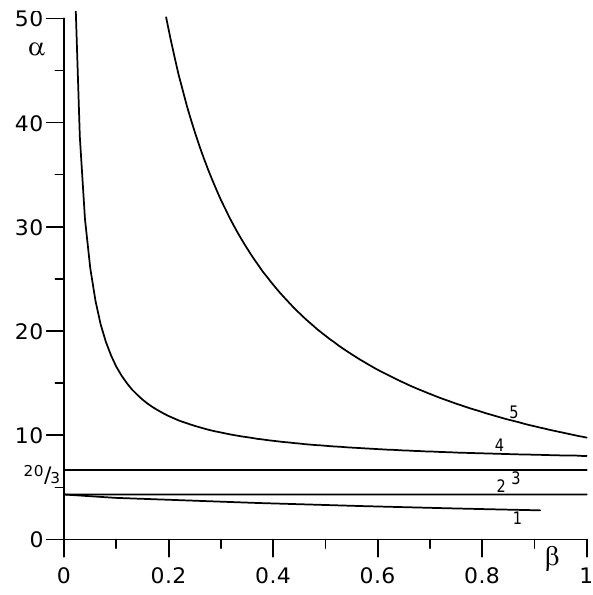
Fig. 4. Stability thresholds of the magnetospheric MHD modes: Flute modes (1 – nonlinear criterion (19), 2 – linear criterion (16), 3 – Gold criterion); Ballooning modes (4 – ballooning modes with ideally conductive ionosphere, 5 – ballooning modes with resistive ionosphere). The region of stability lies below the corresponding boundary.